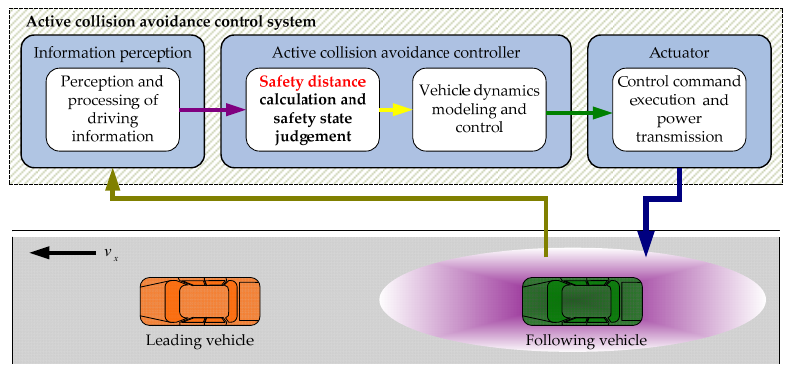
Figure 1. The overall system architecture of active collision avoidance control system.